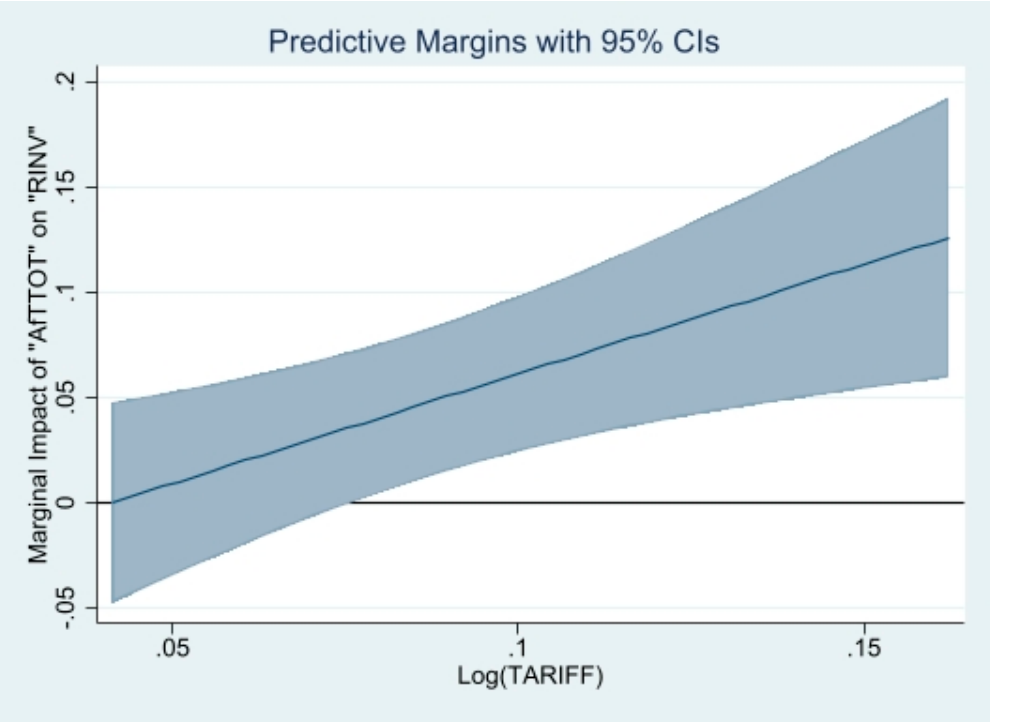
Figure 7. Marginal impact of “AfTTOT” on “RINV” for varying levels of tariff costs. Source: Author.